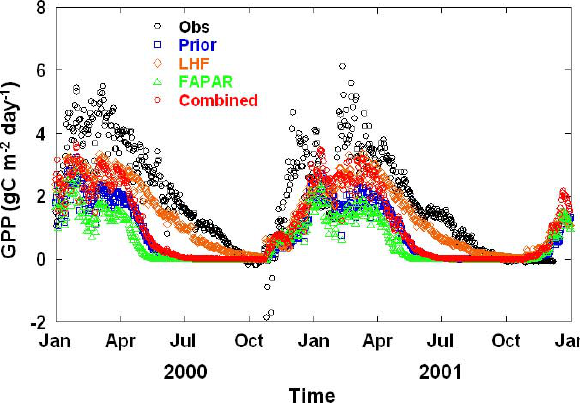
Fig. 5. Daily observed and simulated gross primary production (GPP) for the years 2000–2001. Observed GPP (Obs), based on eddy covariance data, is estimated by subtracting net ecosystem ex- change (NEE) from ecosystem respiration during daytime. Daytime ecosystem respiration is estimated from the relationship between night-time ecosystem respiration and soil temperature. Root mean square errors (RMSEs) of simulated GPP against observation-based values are 1.72, 1.24, 1.87 and 1.45gCm − 2 day − 1 for prior, LHF, FAPAR and combined,